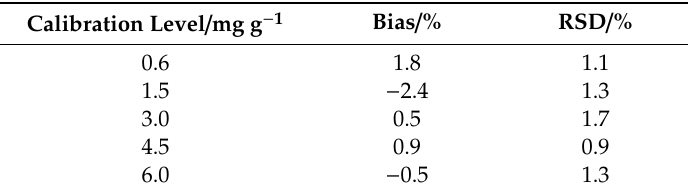
Table 2. Validation parameters for the linear model.